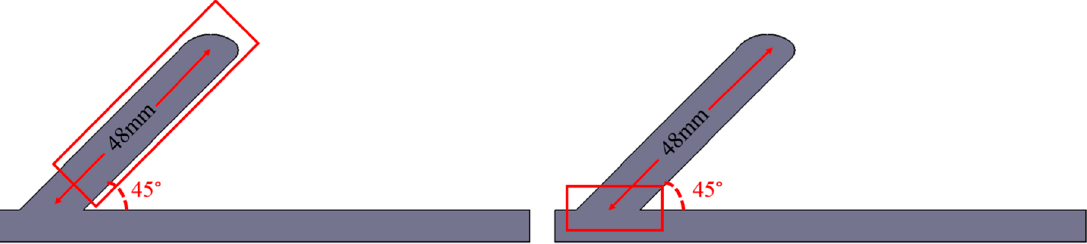
Figure 5. Diagram of metallographic samples’ positions .